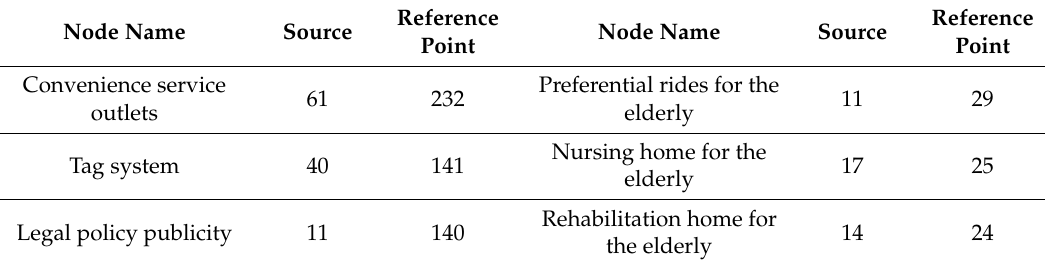
Table 1. Free node information for the policy